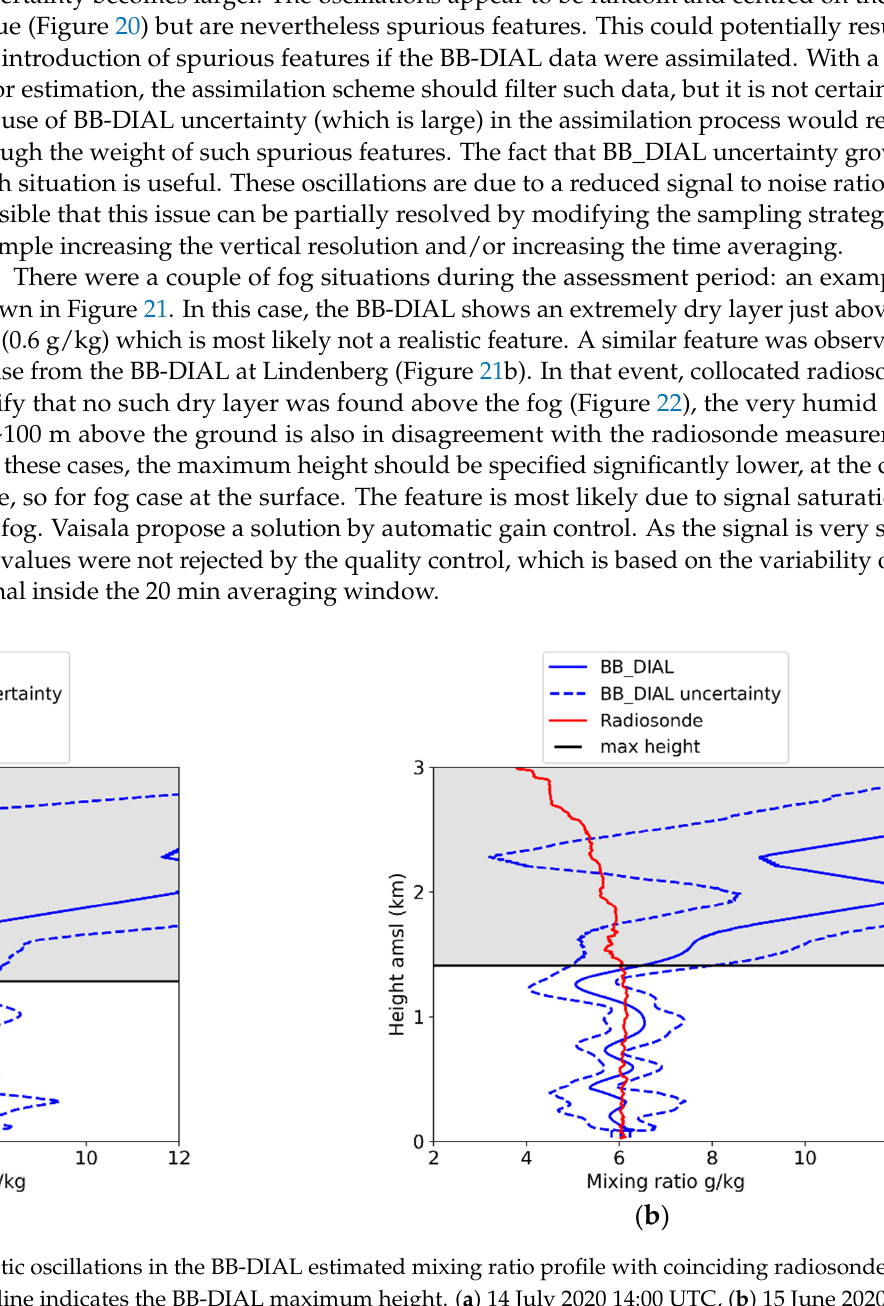
Figure 19. Time height cross section for the full period of the BB-DIAL estimated uncertainty. The horizontal red line is the average height.